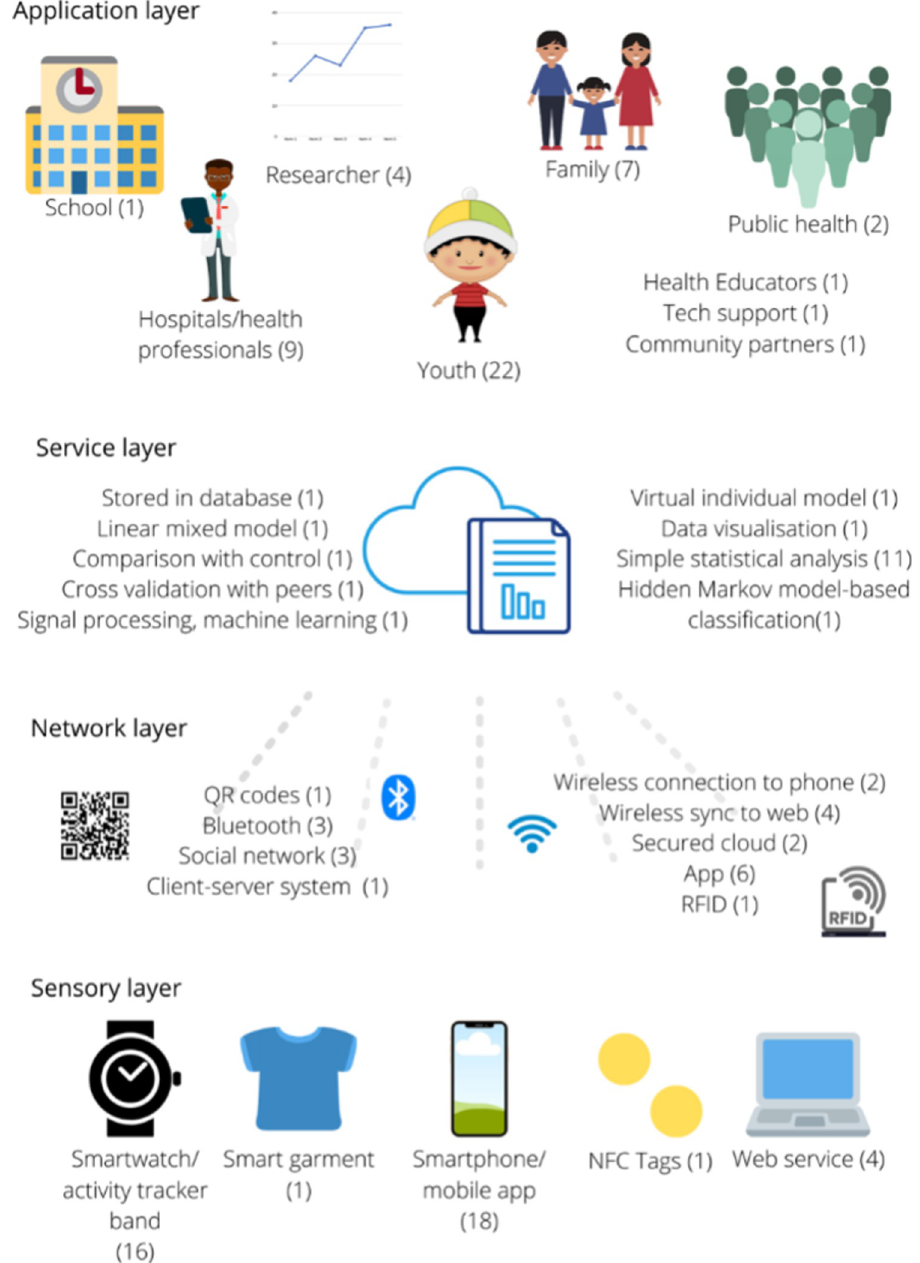
Fig 8. Summary of IoT architecture of included